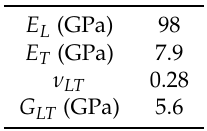
Table 2. Ply material properties (ASI/3501-6 Graphite-Epoxy.